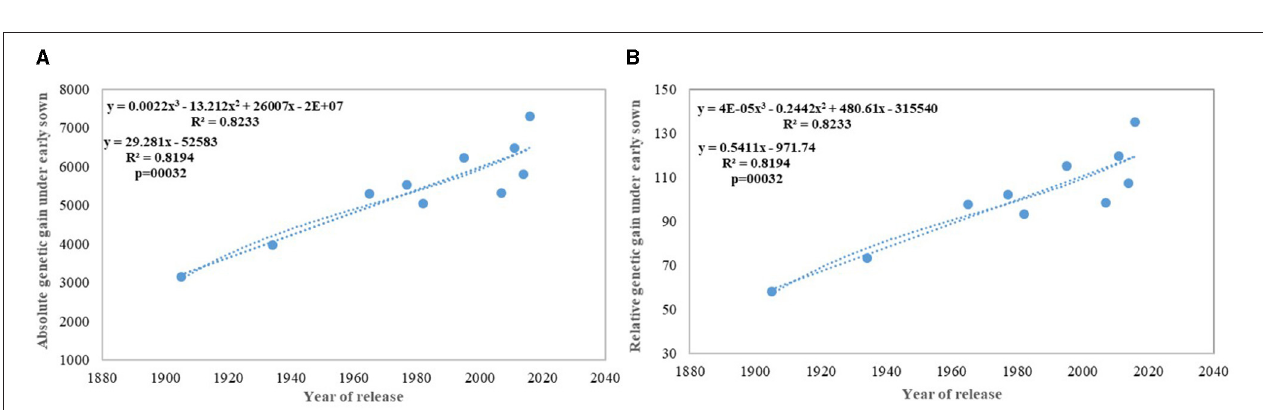
FIGURE 7 | Absolute (A) and relative (B) genetic gain under early sown